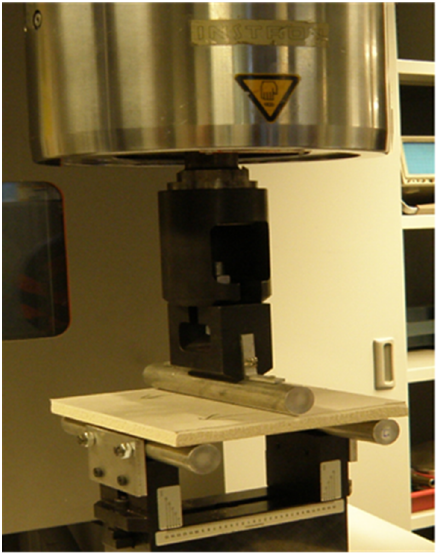
Figure 2. Experimental setup for the 3-point bending test of plasterboards.